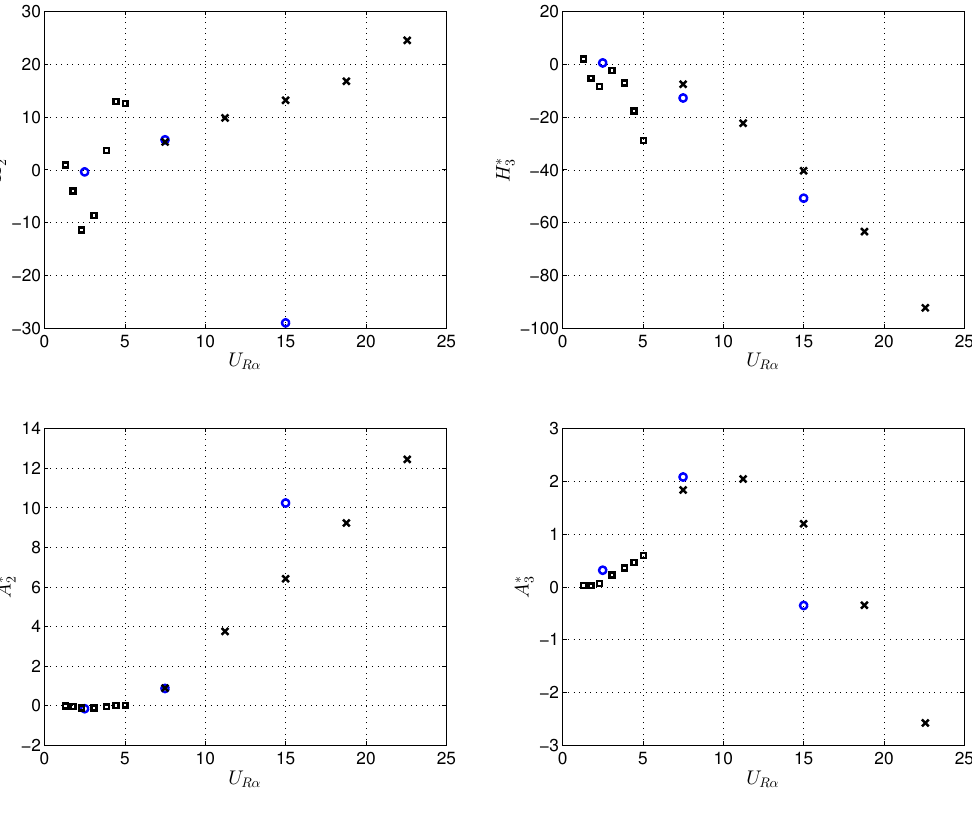
Figure 6. Comparison between measured and calculated flutter derivatives for the rectangular 5:1 cylinder. Experimental data from [43] and [44].